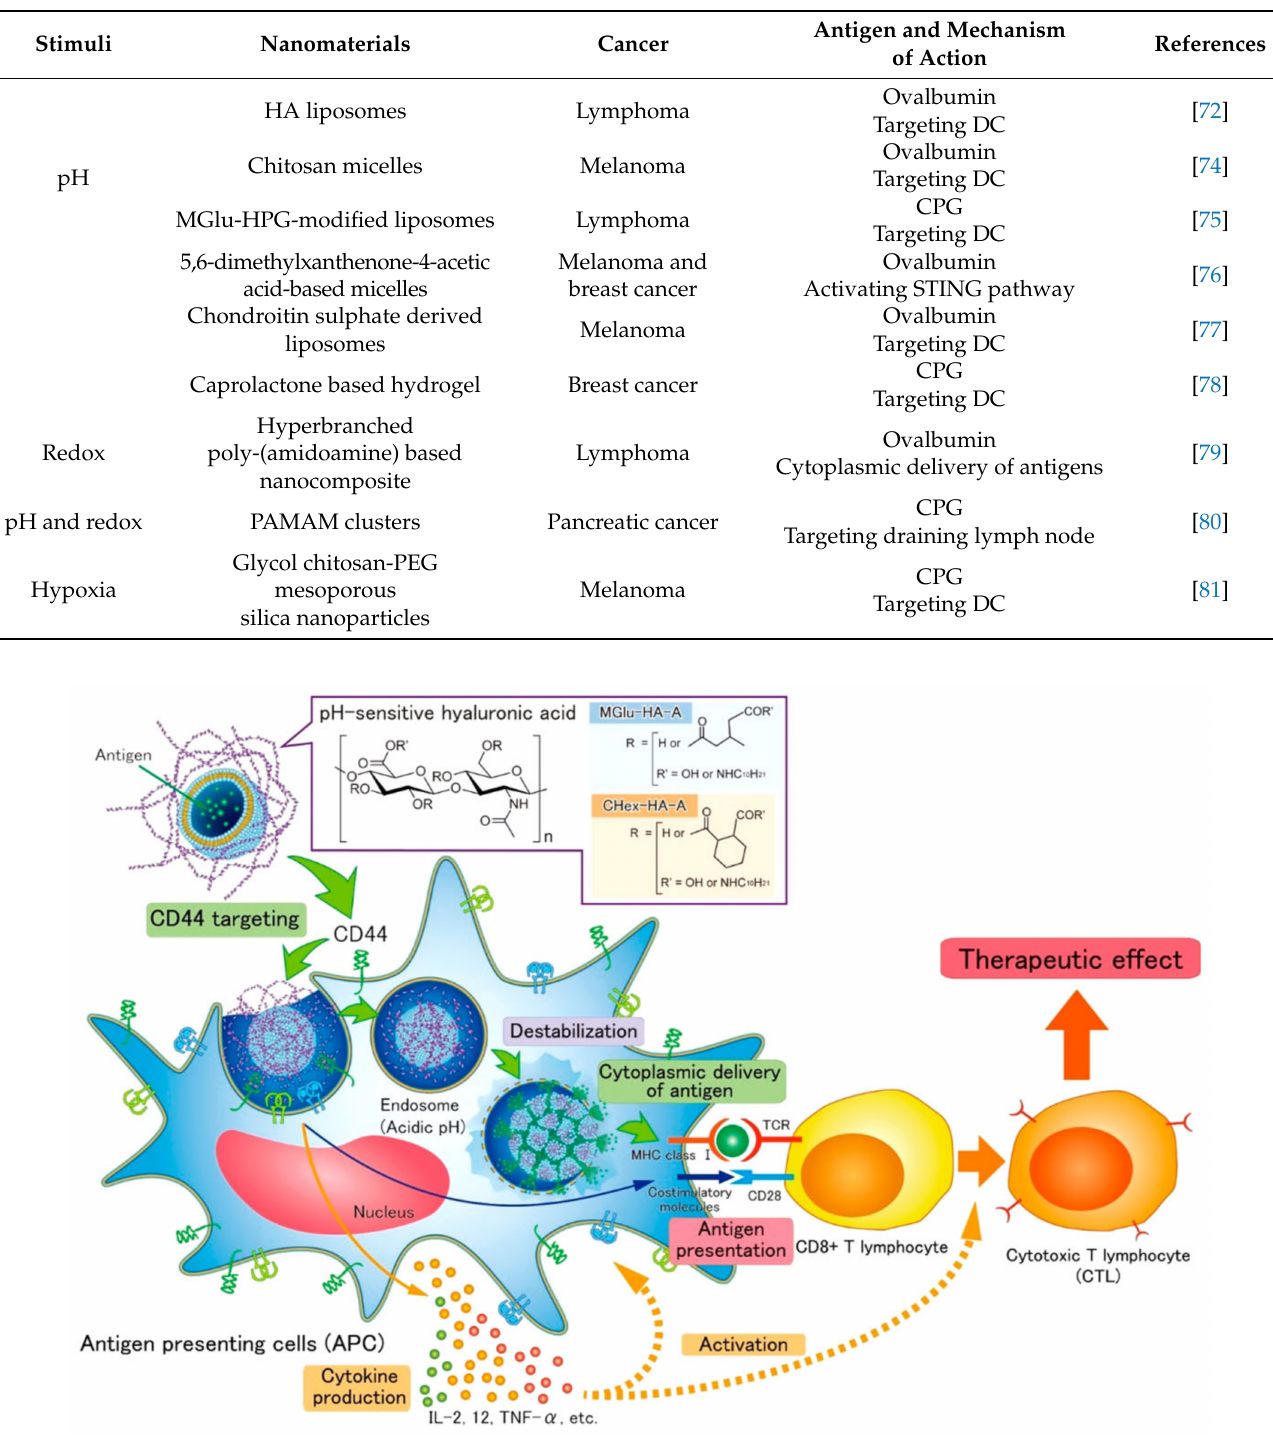
Figure 3. Schematic showing the delivery of antigen-OVA using liposomes with pH-sensitive CD44-specific delivery of hyaluronic acid derivatives [72]. Copyright ACS Biomater. Sci.